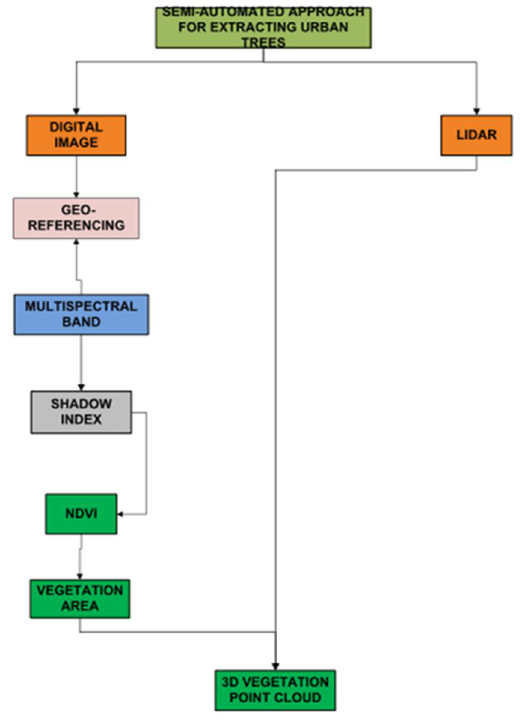
Figure 5: The workflow